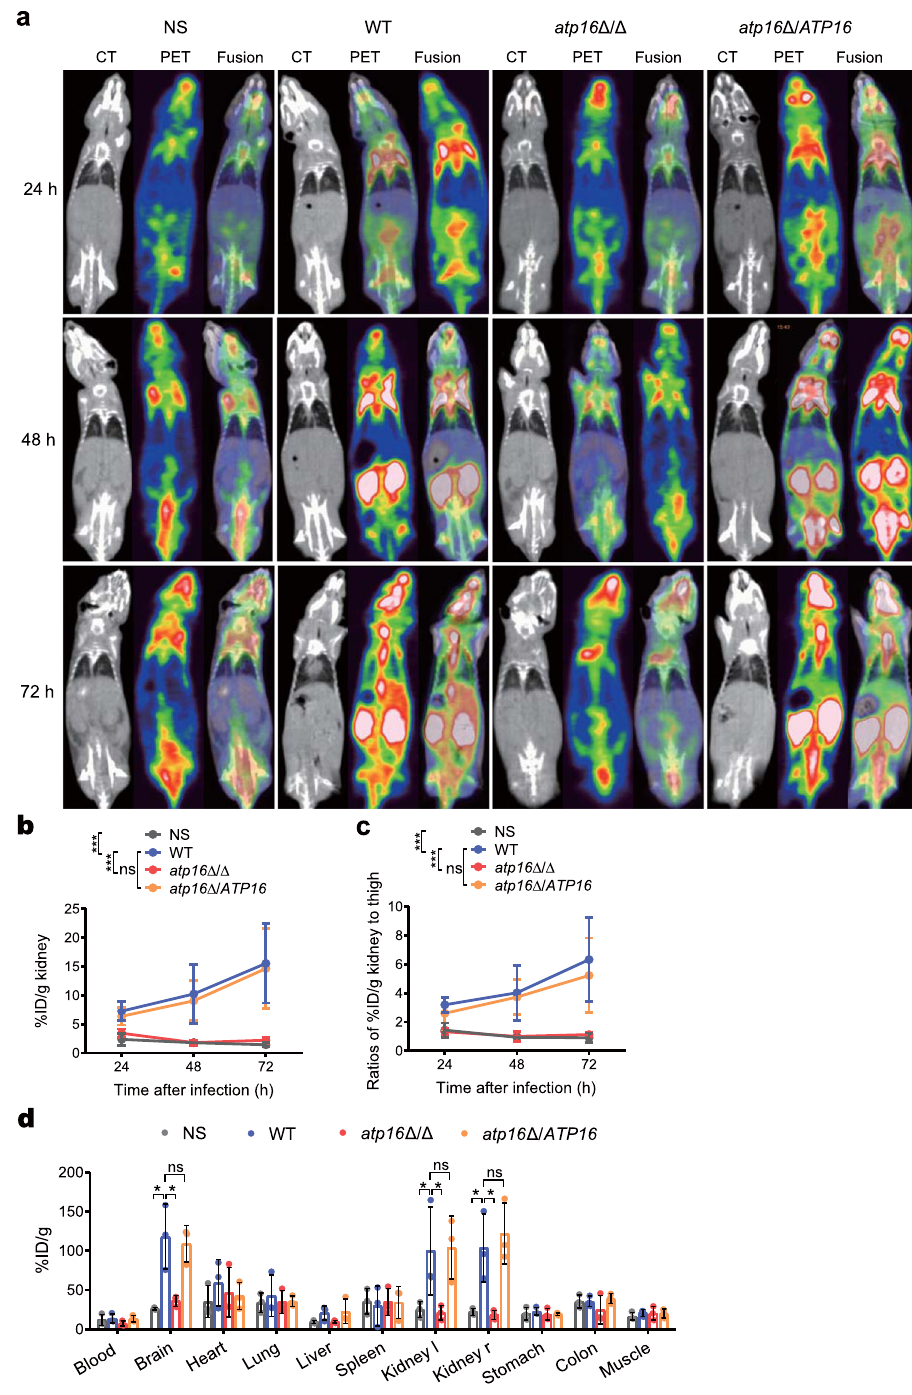
Fig. 2 Deletion of the δ subunit abrogates lethal C. albicans infection as monitored by MicroPET. a CT, PET, and fused PET/CT images of NS-treated mice ( n = 3) and WT-, atp16 Δ / Δ -, and atp16 Δ / ATP16- infected mice ( n = 3) imaged with [ 18 F]FDG (24, 48 and 72h after infection). b Quanti fi cation of the in vivo PET signal intensity of NS-treated mice ( n = 3) and WT-, atp16 Δ / Δ -, and atp16 Δ / ATP16- infected mice ( n = 3) (24, 48 and 72h after infection). c Normalization of the ratios of %ID/g in kidneys to those in the left thigh muscle (24, 48 and 72h after infection). d The ex vivo biodistribution of [ 18 F]FDG in the major organs of NS-treated mice ( n = 3) and WT-, atp16 Δ / Δ -, and atp16 Δ / ATP16- infected mice ( n = 3) injected with [ 18 F]FDG (72h after infection), as assessed with γ counter. Kidney l and Kidney r represent the left kidney and right kidney, respectively. In a one representative experiment of three independent experiments is shown. In b , c and d , data are expressed as the mean±SD. * P <0.05, *** P <0.001; ns, not signi fi cant; by two-way ANOVA ( b , c ), or one-way ANOVA ( d